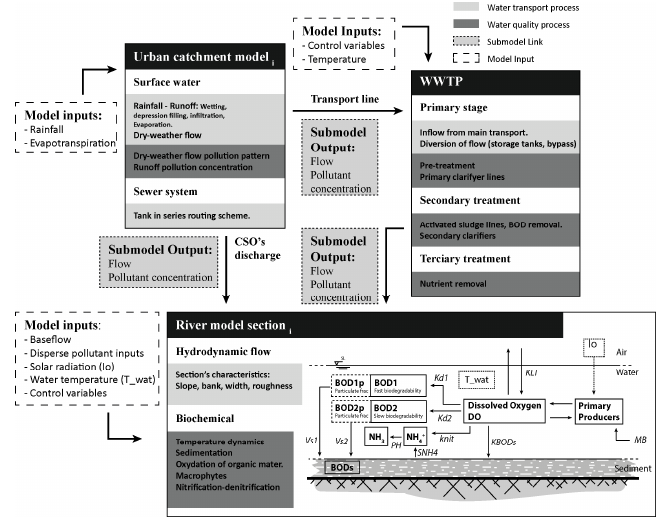
Figure 2. Scheme of sub-model links and processes.